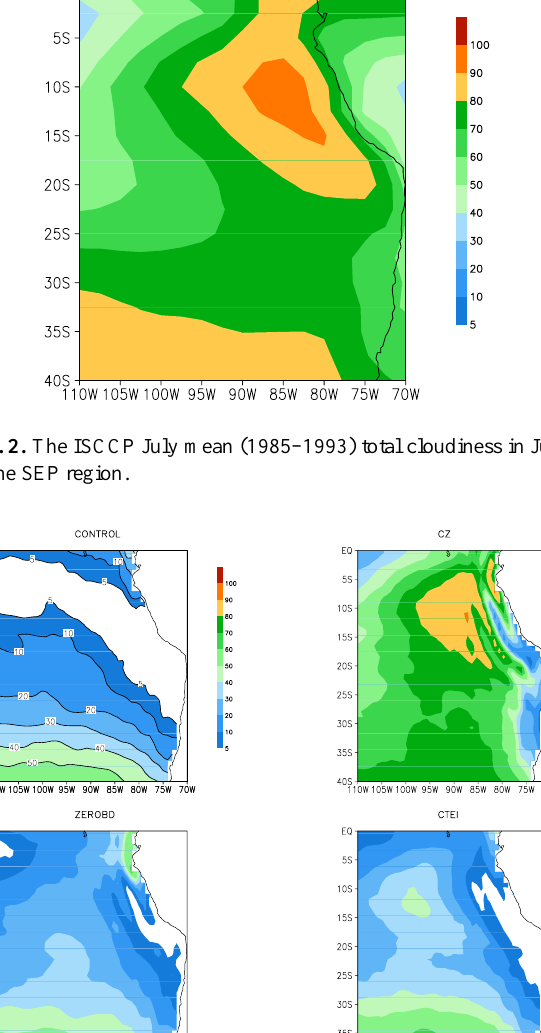
Fig. 5. Vertical cross-section of monthly mean cloud water in July along